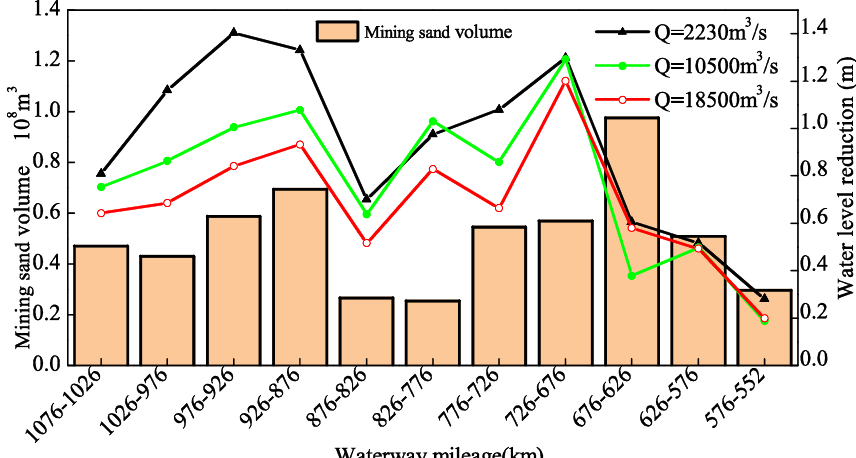
Fig. 23 Sand extraction vol- ume and water level maximum reduction every 50